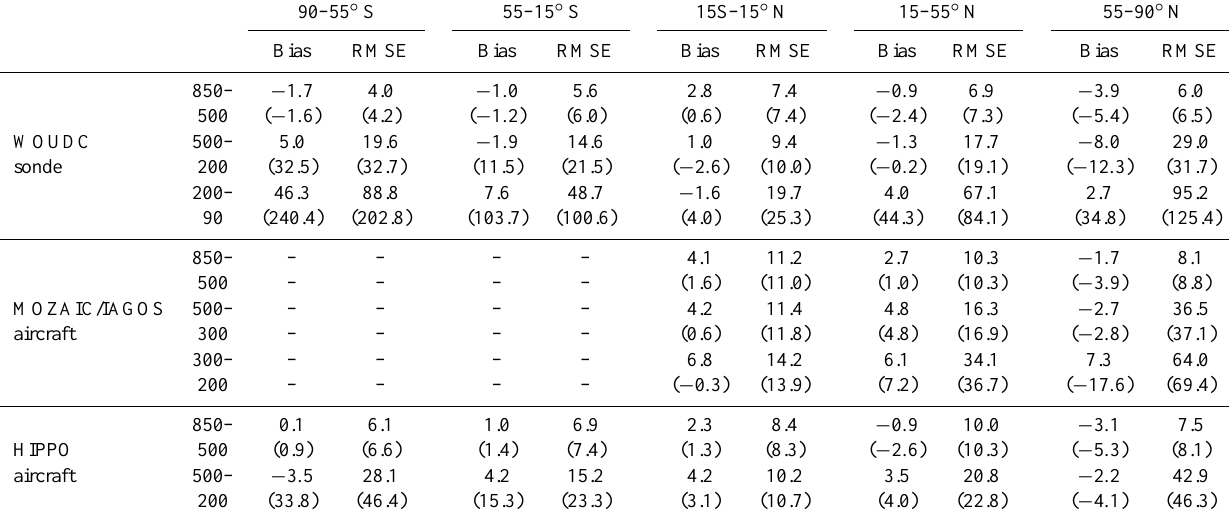
Table 1. Model minus observation comparisons of the mean O 3 concentrations between the analysis or control run (in brackets) and the observations. The units of the root-mean-square error (RMSE) and bias are ppb. Results are provided for WOUDC ozonesonde observations during 2005–2012, MOZAIC/IAGOS aircraft measurements during 2005–2012, and HIPPO aircraft measurements during 2009–2011.